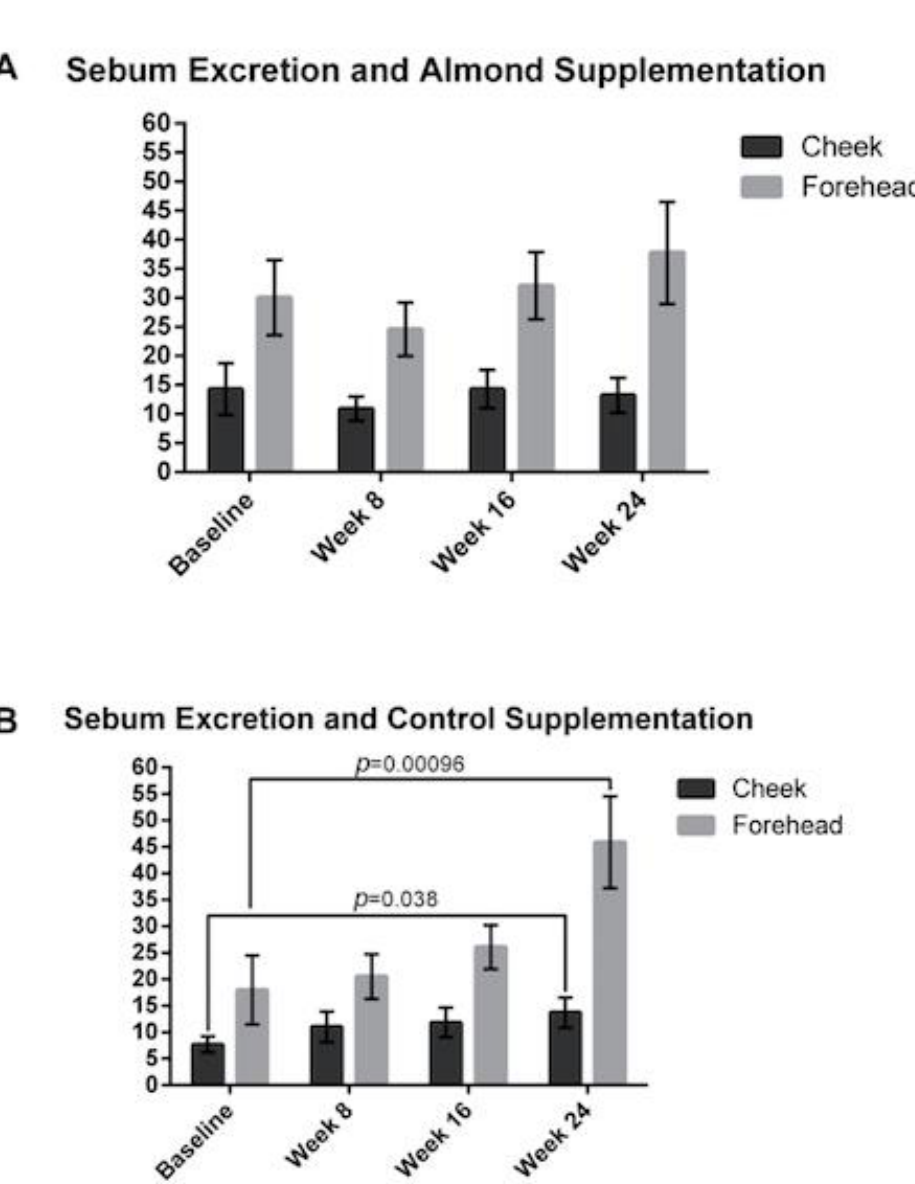
Figure 7. Changes in sebum excretion of the forehead and cheek were measured at baseline, 8, 16 and 24 weeks with ( A ) almond and ( B ) control supplementation. Sebum excretion rates were increased in the control supplementation group but not in the almond supplementation group. Significant p values are noted on the figure. Error bars represent SEM.